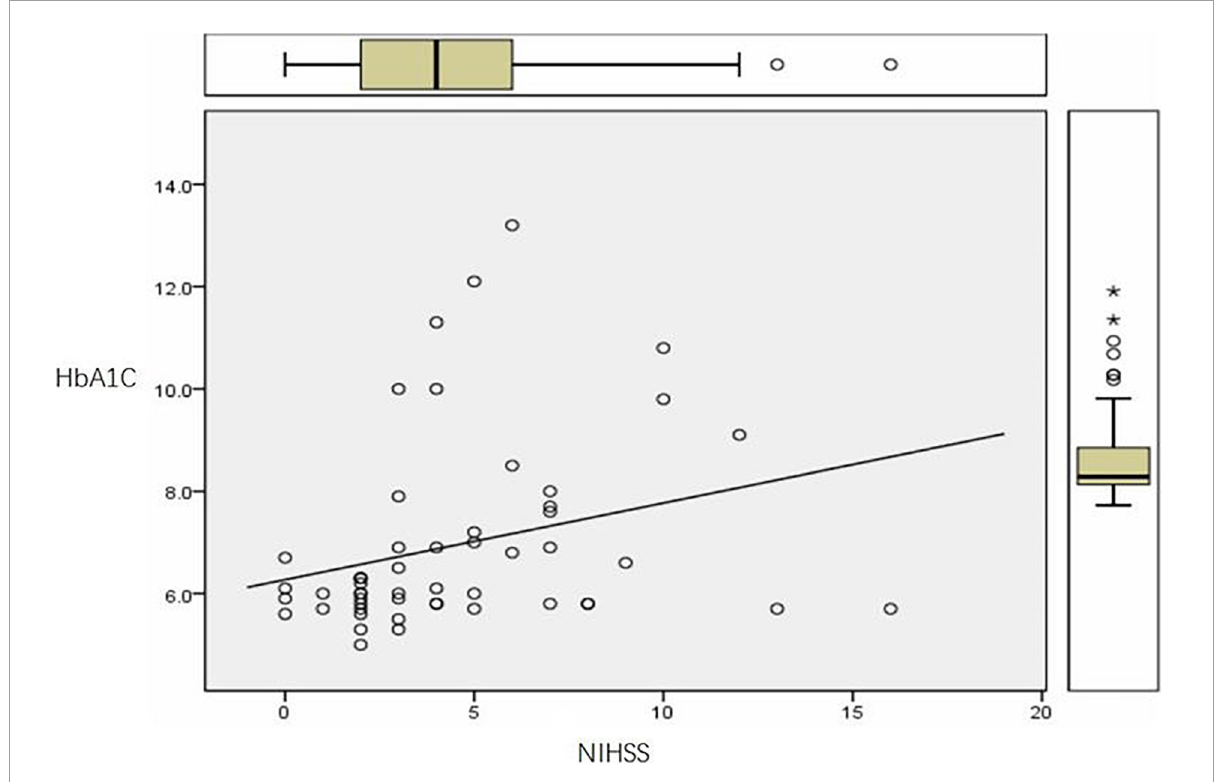
FIGURE1 HbA1C and NIHSS